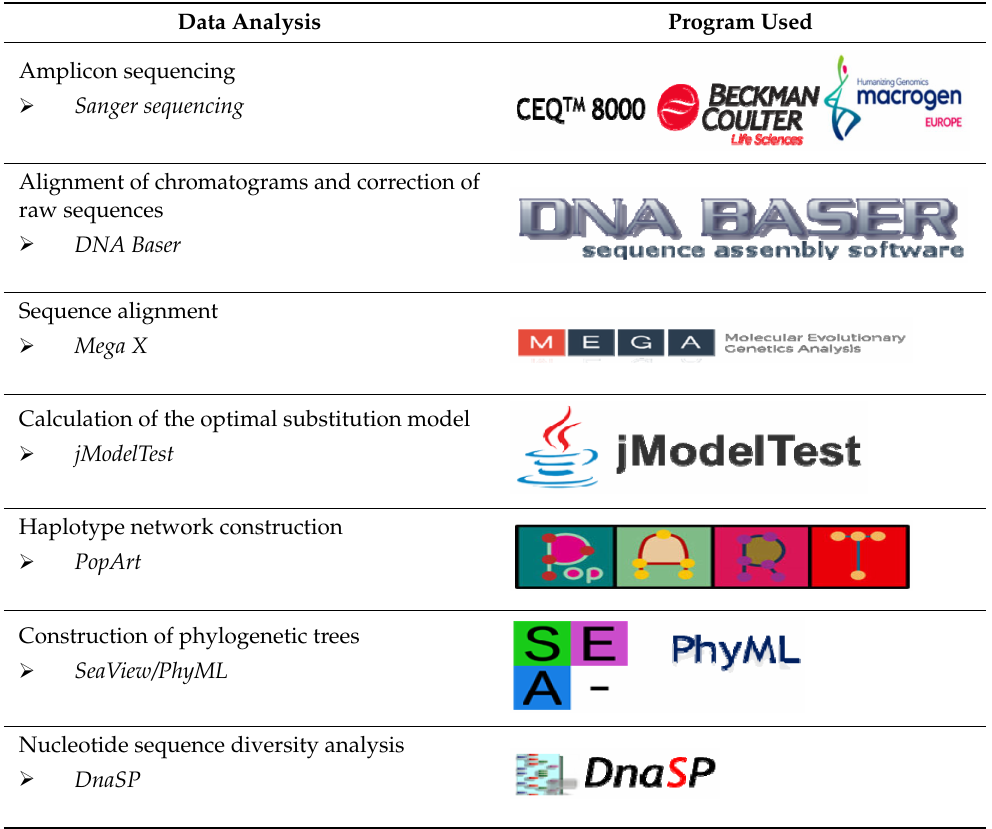
Table 4. List of programs used for data analysis.